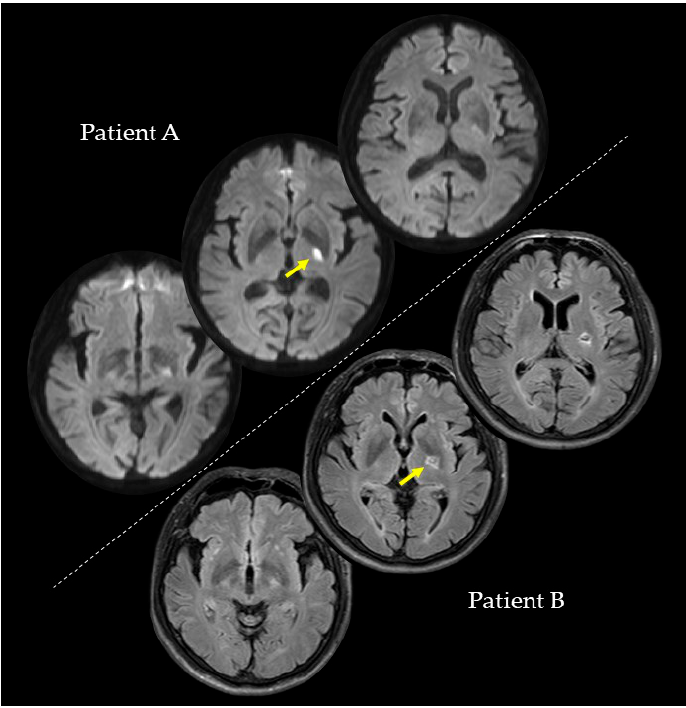
Figure 1. Magnetic resonance imaging scans showing the lesion sites of Patients A and B. Yellow arrows indicate the lesion